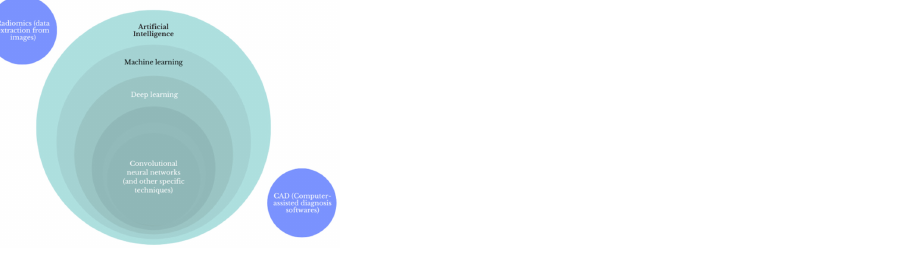
Figure 1. Schematic definition of artificial intelligence, machine learning, deep learning, and convolutional neural networks.